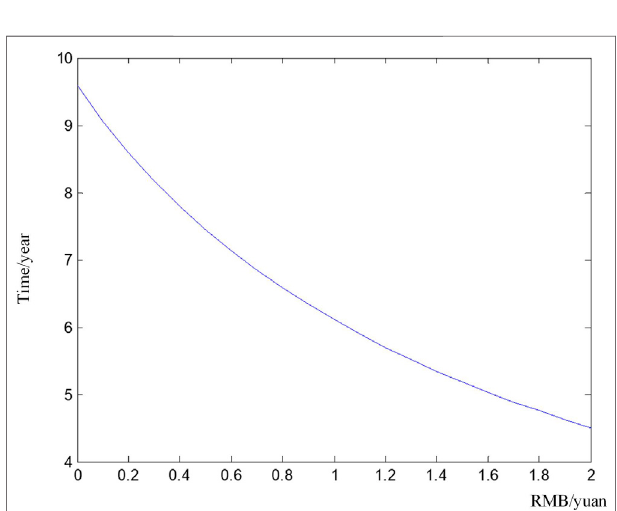
FIGURE 10 | DPP of BESS for government subsidy price changes.